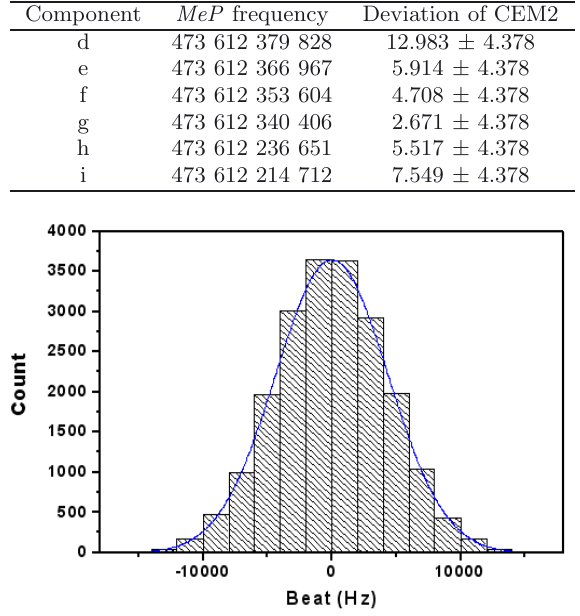
Fig. 7. Histogram of counting quality of f beat of standard laser with femtosecond